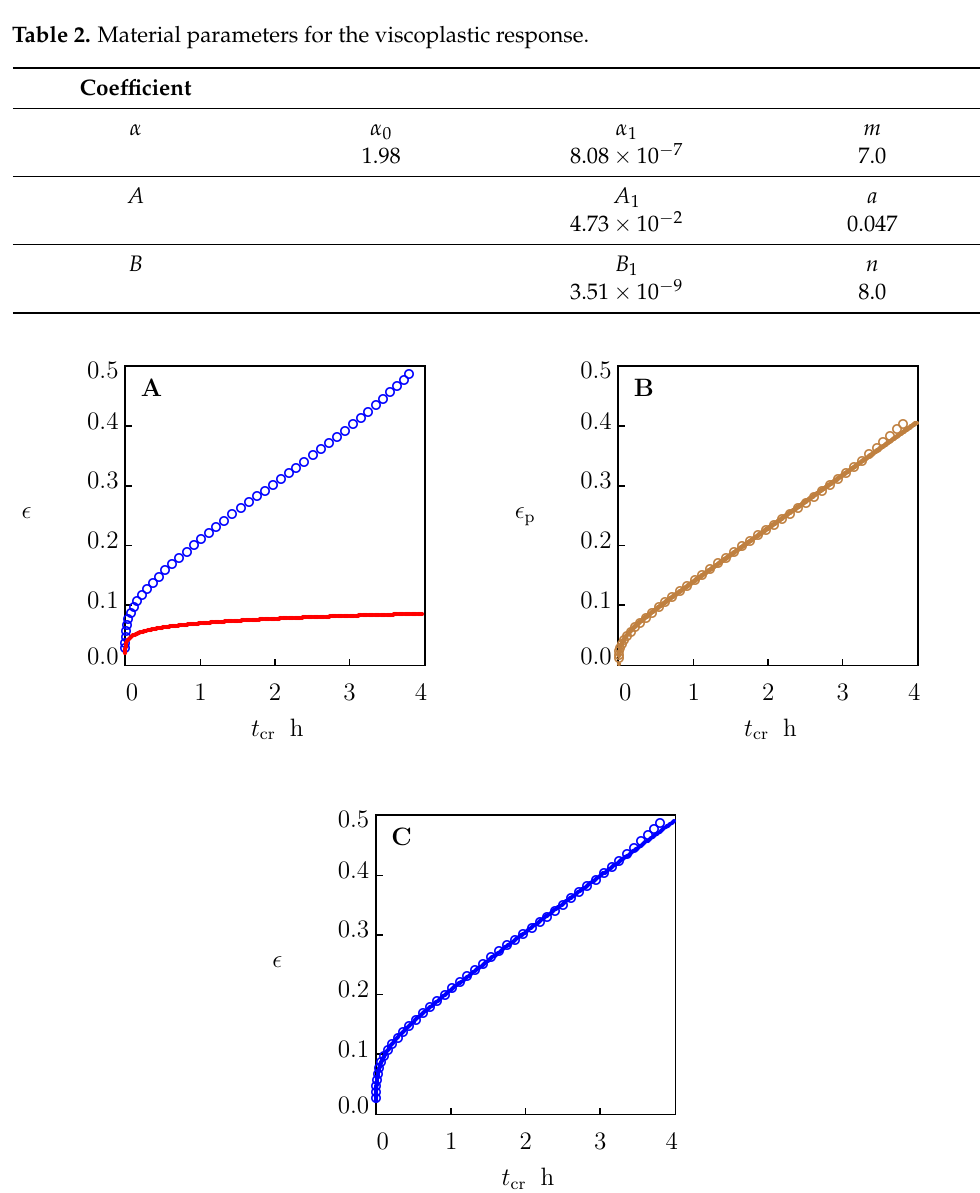
Figure 4. ( A ) Tensile strain (cid:101) versus creep time t cr . Circles: experimental data in creep tests with tensile stress σ =17.5 MPa. Solid line: prediction of the model in linear viscoelasticity. ( B ) Plastic strain Figure 4: A – Tensile strain (cid:15) versus creep time t . Circles: experimental data in creep tests cr (cid:101) p versus creep time t cr . Circles: treatment of experimental data. Solid line: results of simulation with tensile stress σ = 17 . 5 MPa. Solid line: prediction of the model in linear viscoelasticity. based on the model in viscoplasticity. ( C ) Tensile strain (cid:101) versus creep time t cr . Circles: experimental B – Plastic strain (cid:15) versus creep time t . Circles: treatment of experimental data. Solid data. Solid line: results of simulation based on the model in cr line: results of simulation based on the model in viscoplasticity. C – Tensile strain (cid:15) versus creep time t . Circles: experimental data. Solid line: results of simulation based on the cr model in viscoelastoplasticity.